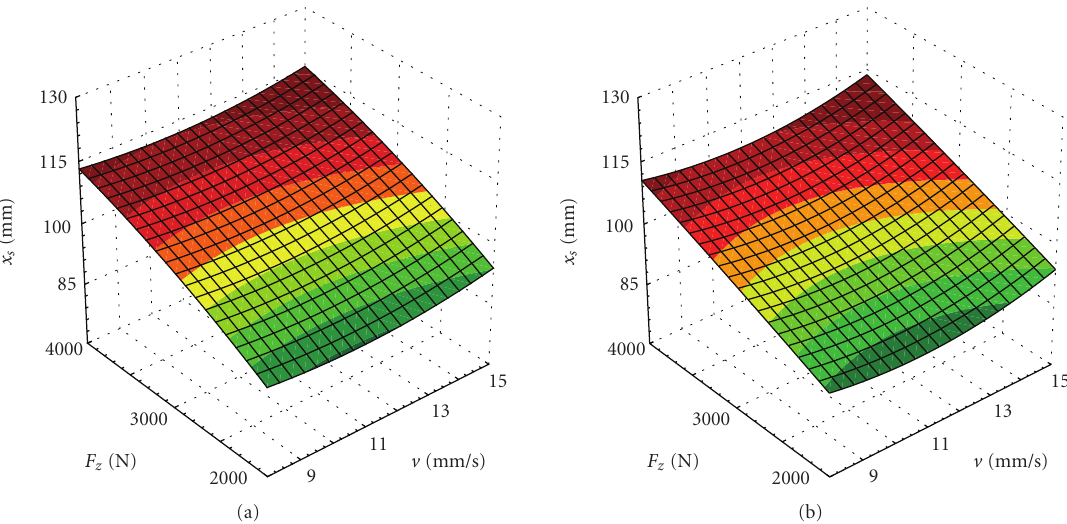
Figure 15: Cohesion contact length of rolling tire in braking mode: (a) for upper tread element from Figure 13(a) ; (b) for lower tread element from Figure